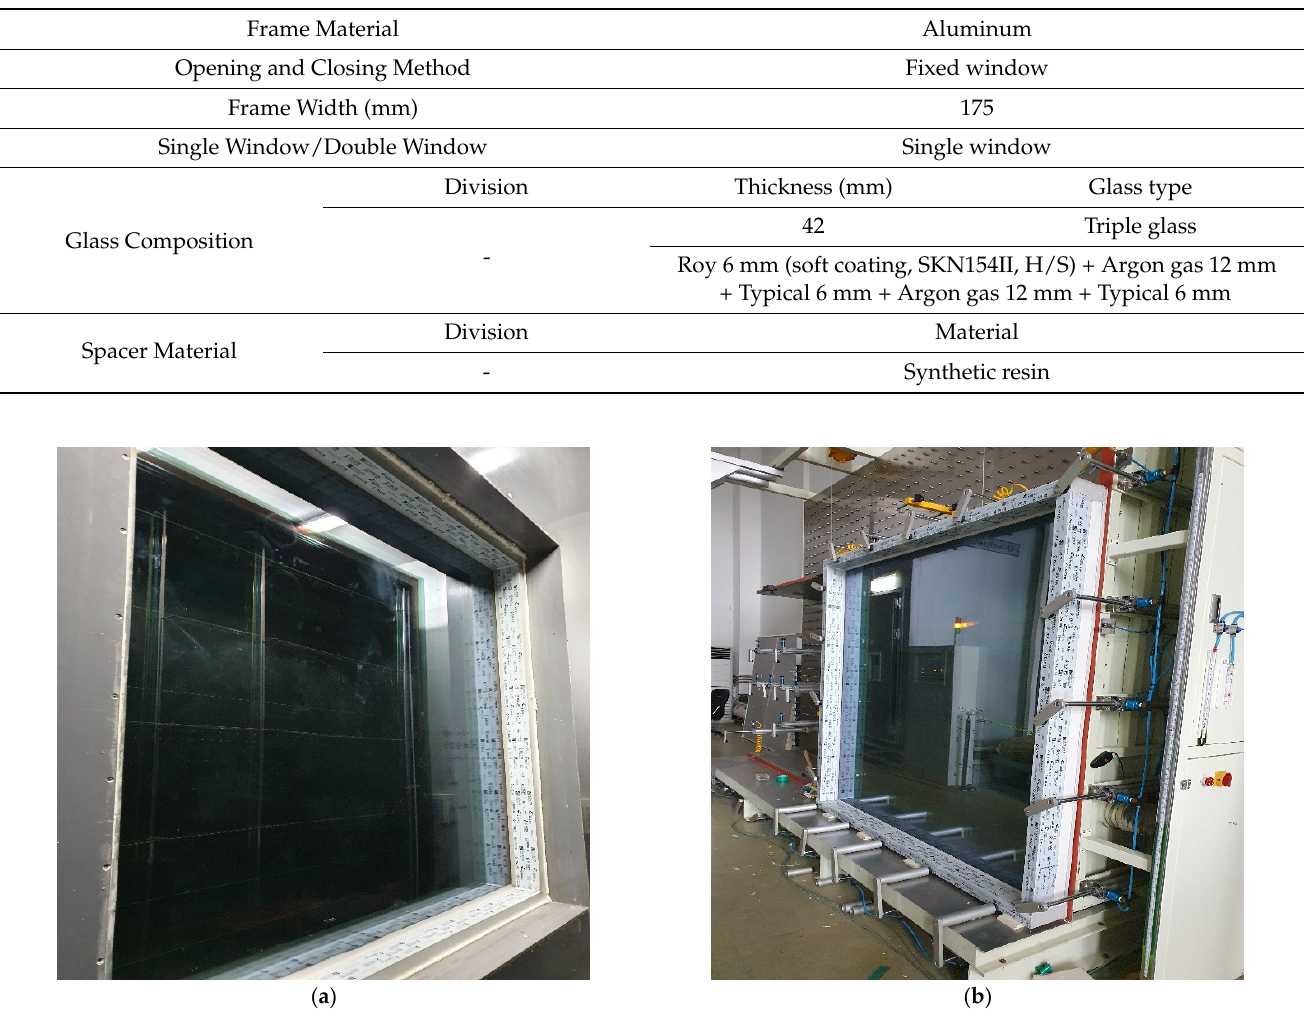
Table 12. Specimen specifications for evaluation of heat insulation and airtightness performance (and/or watertightness and wind pressure).